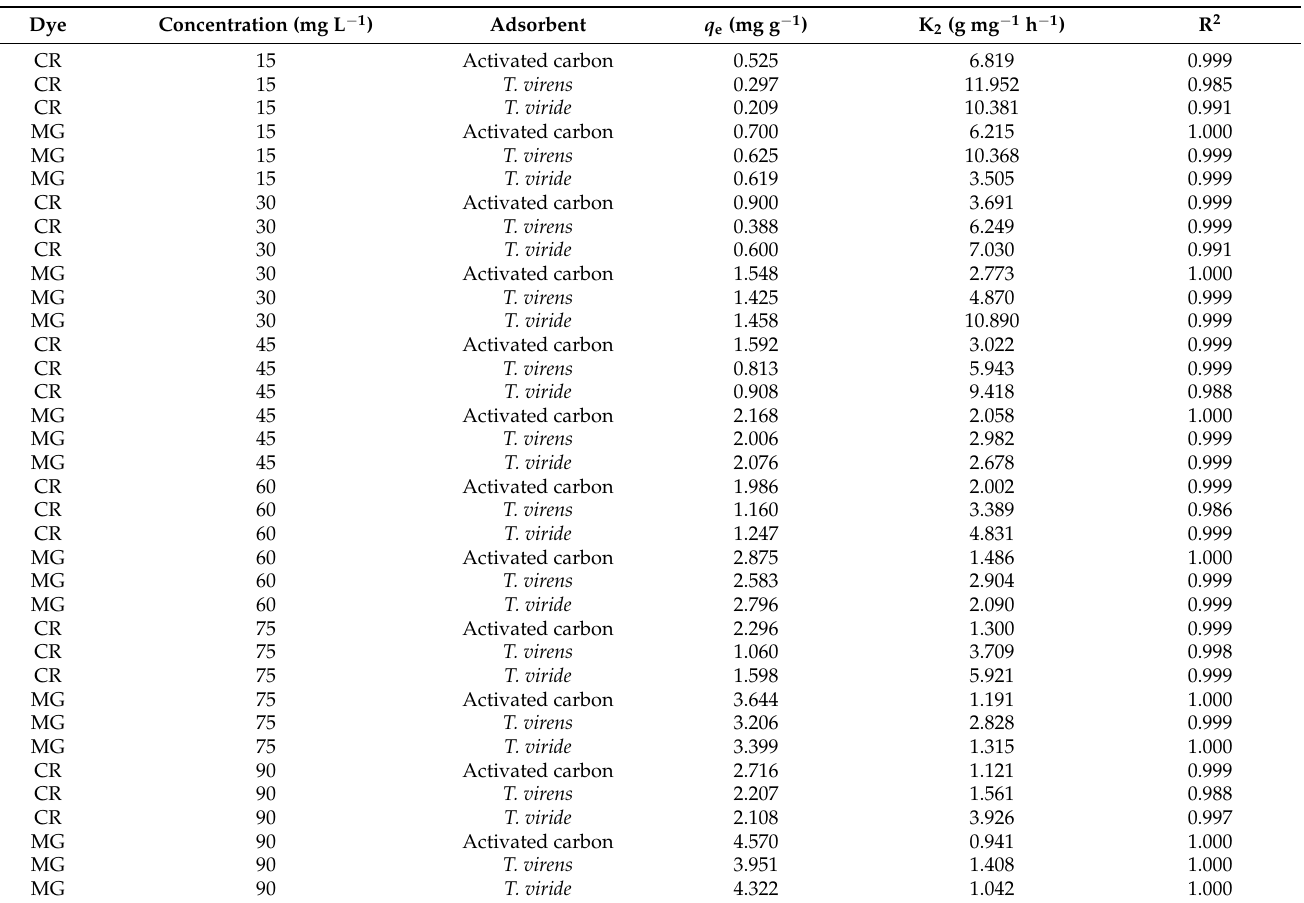
Figure 6. Pseudo-second-order model fit plot for activated carbon and fungal dry biomass of T. virens and T. viride . ( A ) Congo red and ( B ) malachite green. Table 5. Pseudo-second-order kinetic parameters for the removal of Congo red and malachite green by fungal dry biomass of T. virens and T. viride. Dye